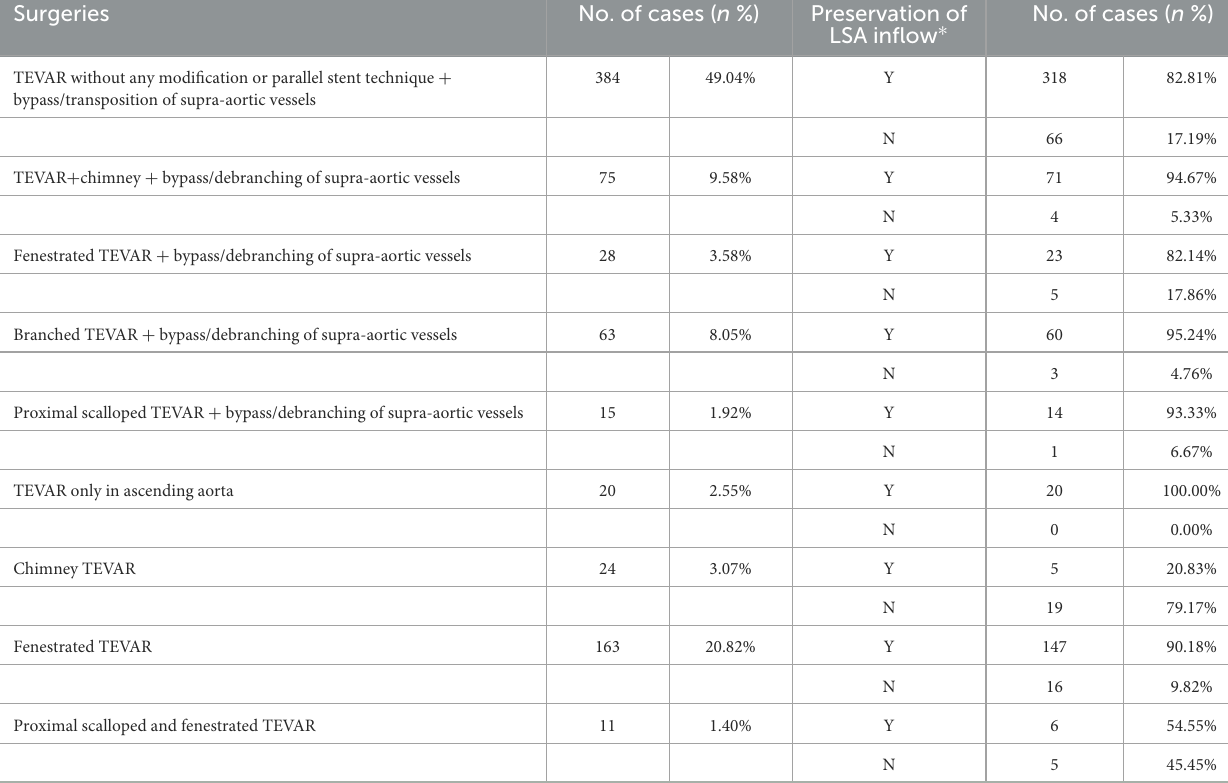
TABLE 5 Surgery details and LSA information ( N =